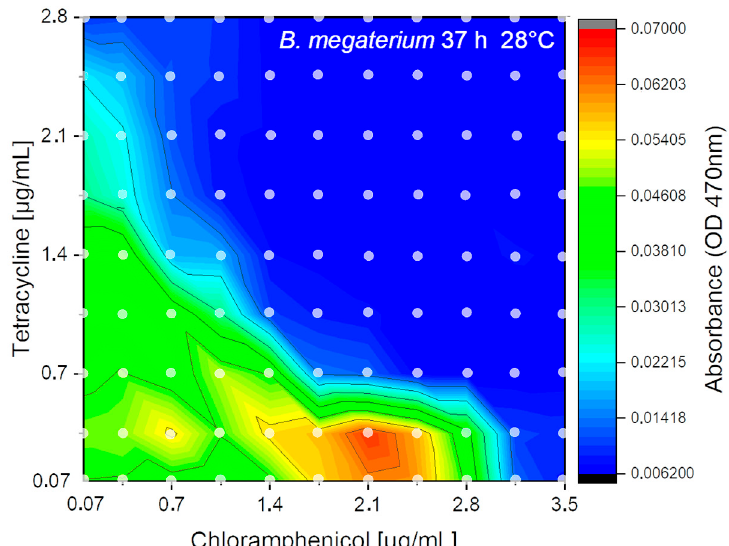
Figure 13. 2D-isobolic plot of B. megaterium cell density signal (OD470) recorded after 37 h incubation with a combination of two di ff erent antibiotics (tetracycline (0.05–2.8 µ g / mL), chloramphenicol (0.05–3.5 µ g / mL)). Dots indicating measured data points averaged from about 12 droplets.